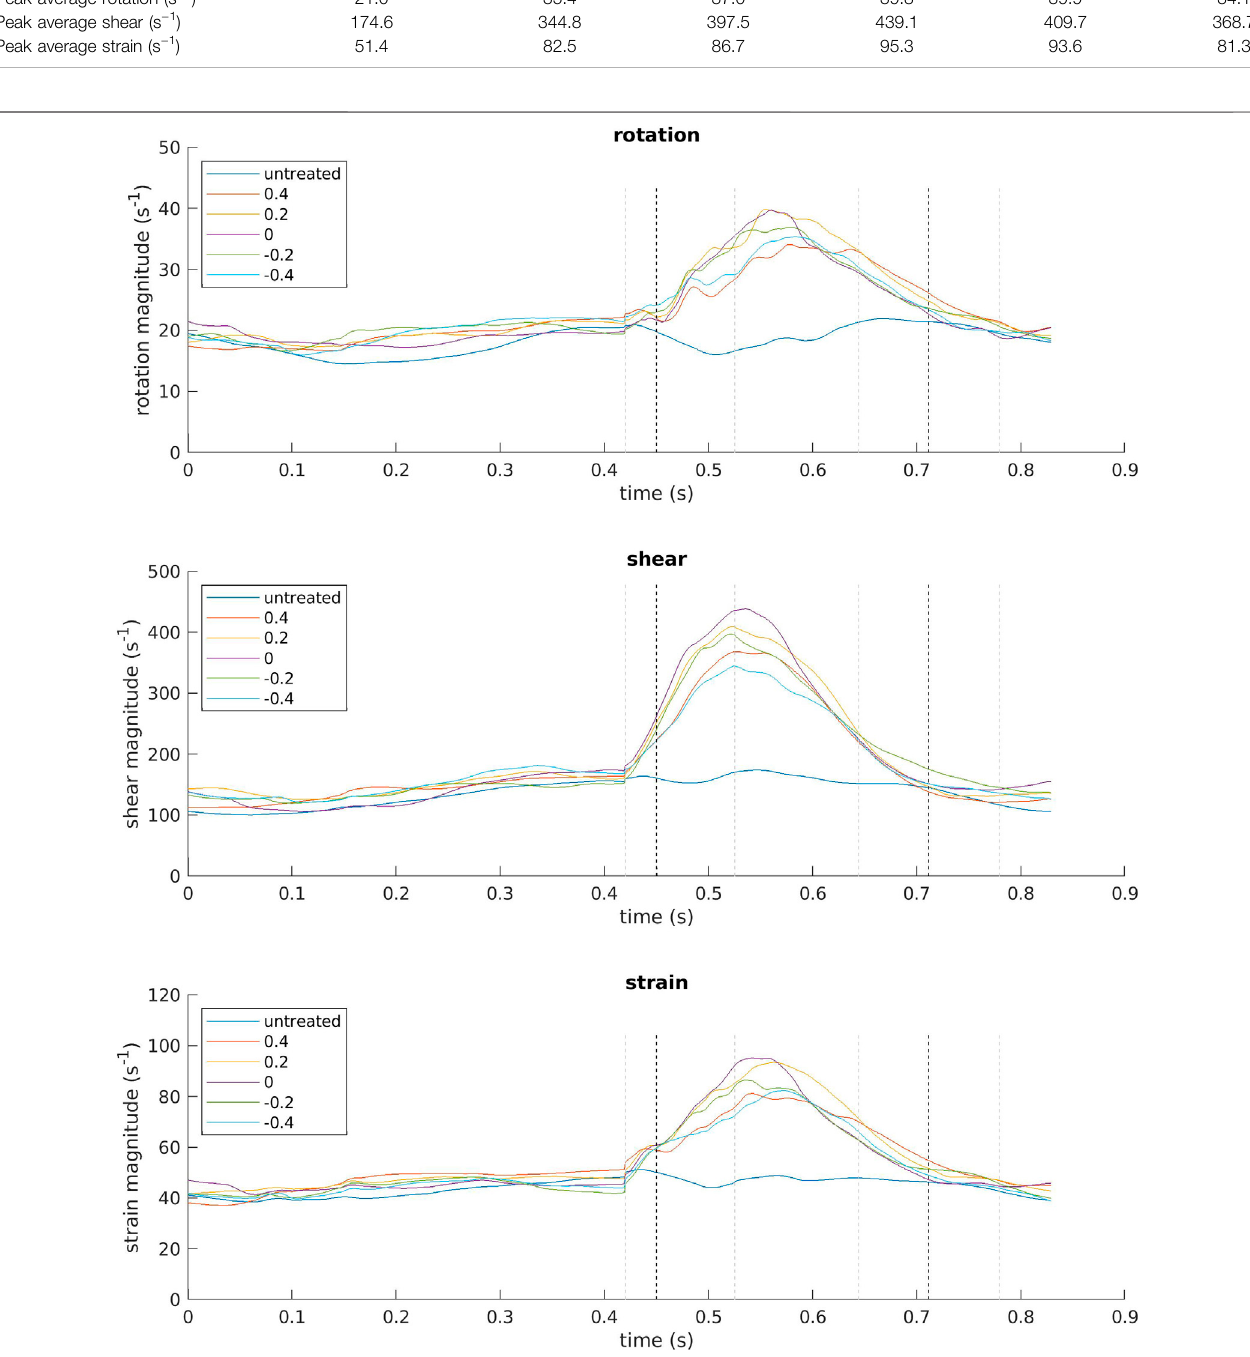
FIGURE5| Magnitudesofrotation,shearandstrainaveragedovertheentireventriclevolumeandplottedagainsttimeoveroneheartbeat,startingwithsystole,for all simulated cases. The legend indicates the location of the MVC as relative shift from the center of the coaptation line, except for the healthy (untreated) case. The gray dashed lines mark the time of the start of diastole, E-wave peak, diastasis start, and A-wavepeak, also given in Table 1 . The black dashed lines mark t = 0.45 s and t = 0.71 s, i.e. the times at which the blood fl ow is visualized in Figures 3 , 4 , 6 – 9 . Frontiers in Physiology |